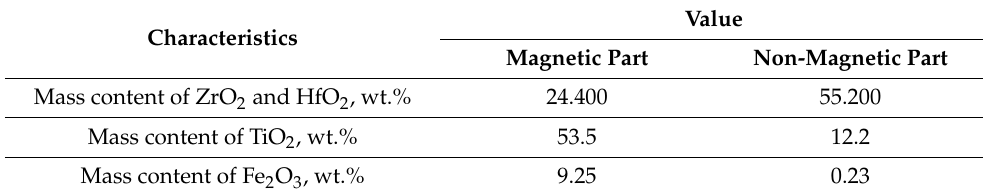
Value Magnetic Part Non-Magnetic Part